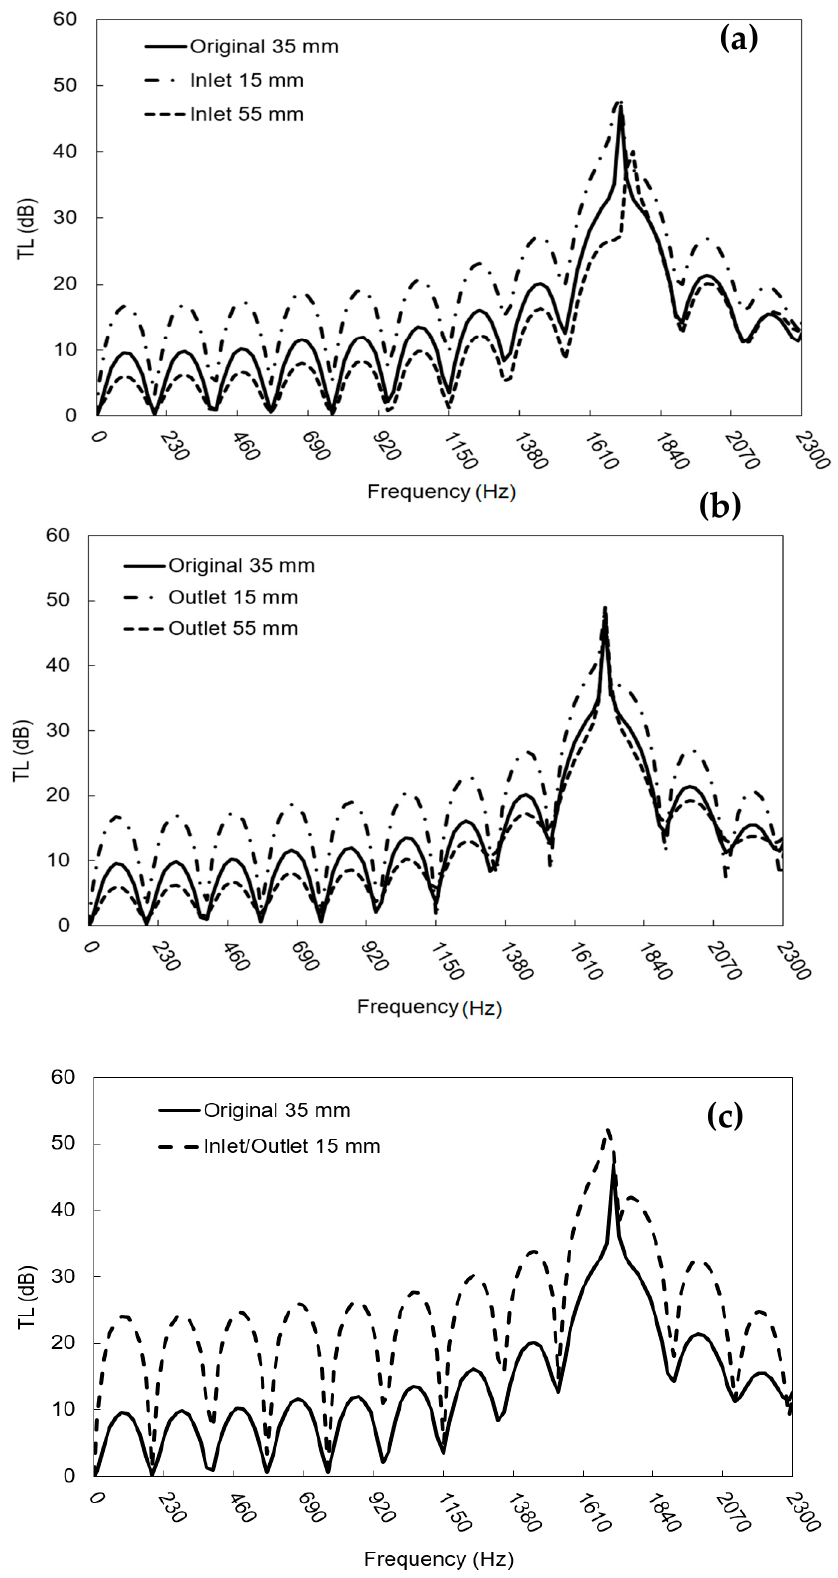
Figure 15. Influence of the pipe diameters on the model-scale scrubber TL: ( a ) inlet pipe, ( b ) outlet pipe, ( c ) combined inlet/outlet